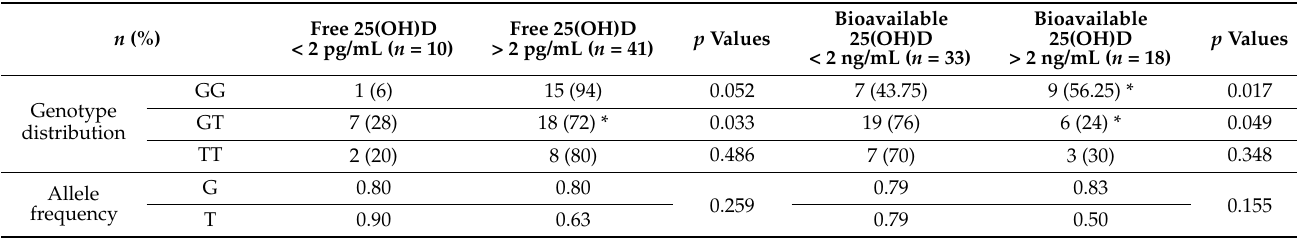
Table 2. Genotype distributions and allele frequencies of individuals with rs7041 polymorphism, grouped according to free and bioavailable 25(OH)D levels.